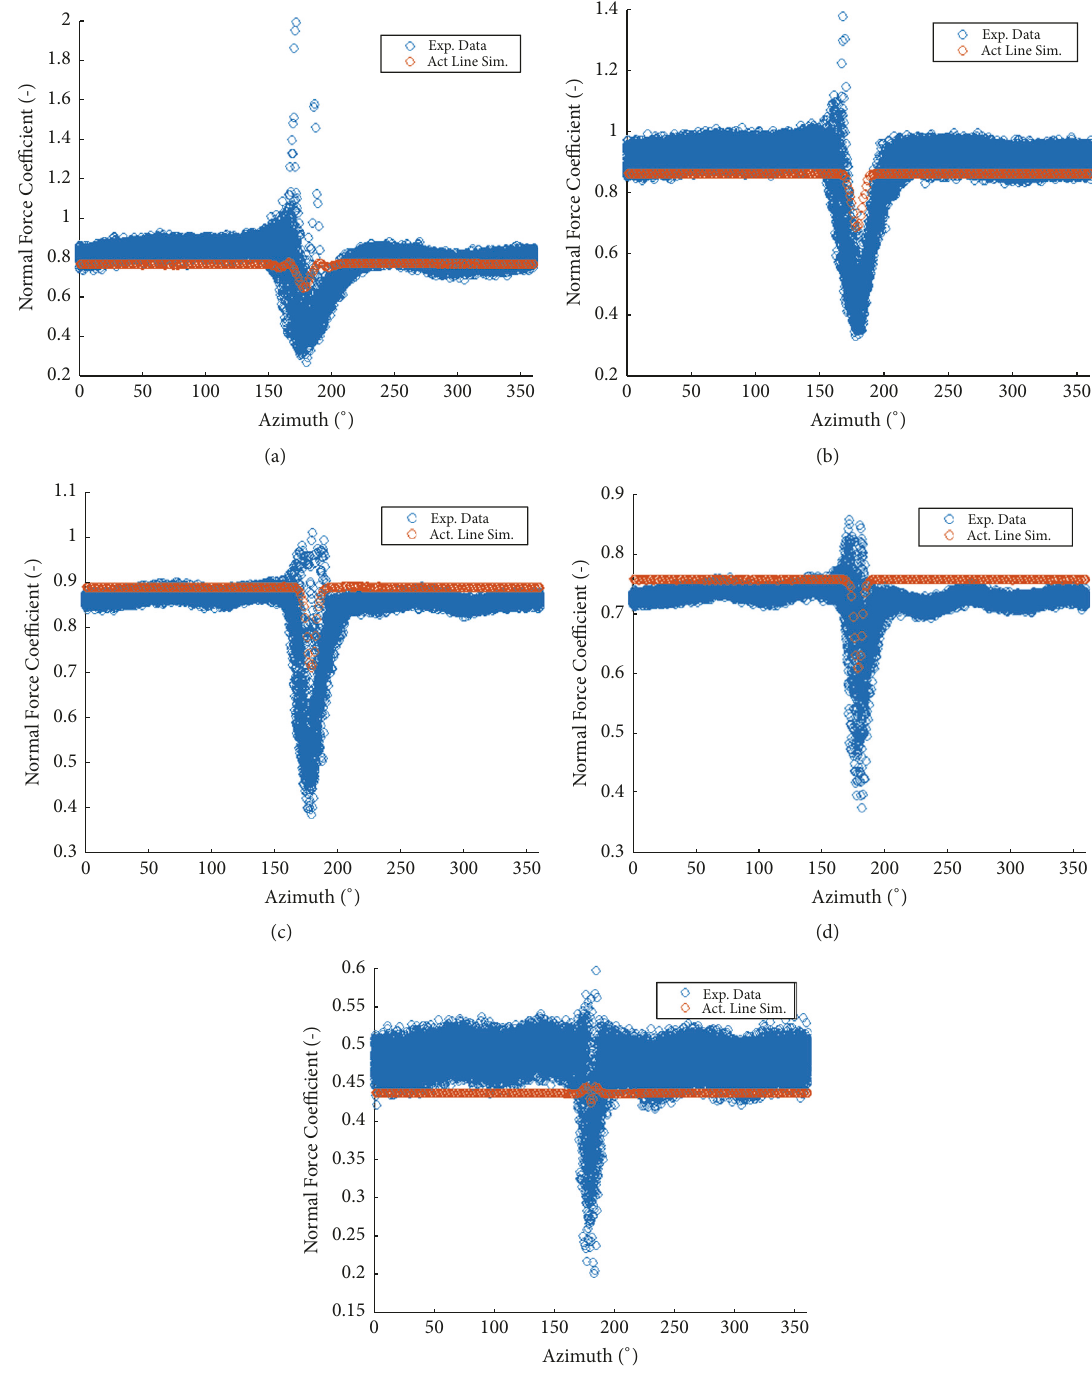
Figure 7: Normal force coefficients for five sections at different span positions of the blade: (a) 30%, (b) 47%, (c) 63%, (d) 80%, and (e) 95%. meaning because it establishes the fact that the distances over the forces are projected on the